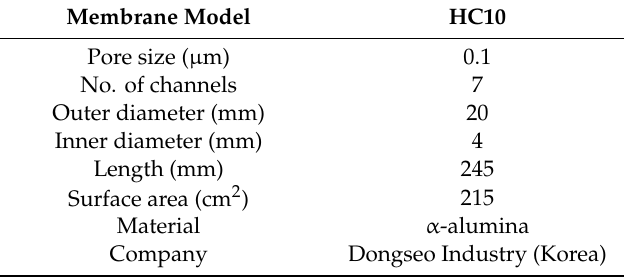
Table 1. Specifications of multichannel ceramic microfiltration (MF) membrane used in this